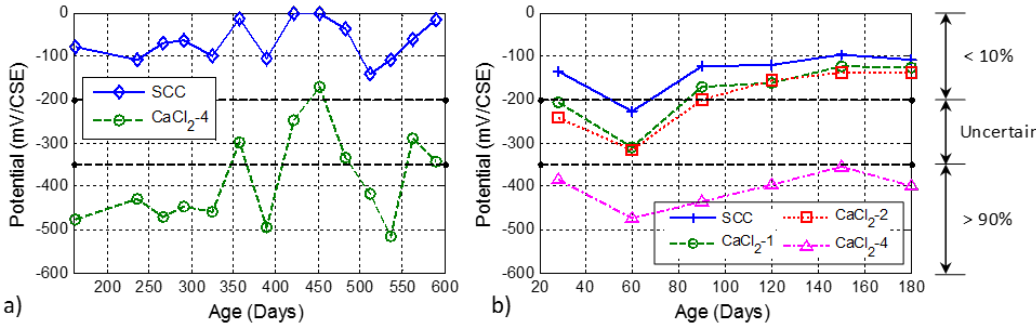
Figure 11. Open circuit corrosion potential of ( a ) SCC and CaCl 2 -4 mixtures from the larger batch series and ( b ) CaCl 2 mixtures from the smaller batch series. Note that the horizontal dashed lines are the limits in ASTM C876 (2015).